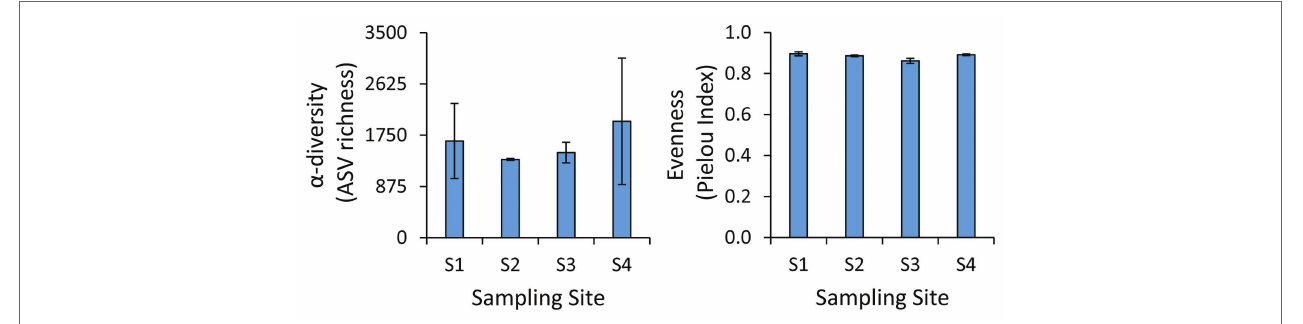
FIGURE 2 | Values of α -diversity and evenness at the benthic sites investigated. Average values and SD are